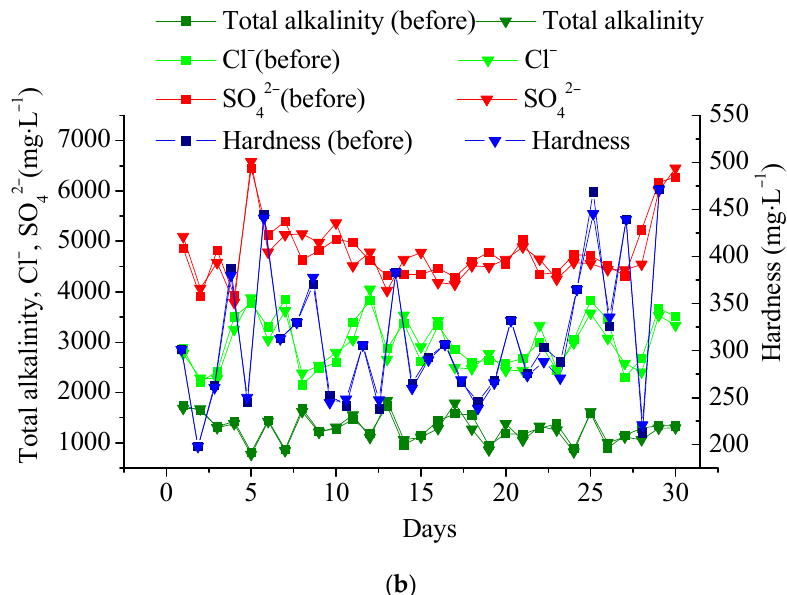
Figure 9. Pollutants change in the second ozonation process ( a ) conductivity and turbidity, ( b ) hardness, total alkalinity, Cl − , SO 42 − .